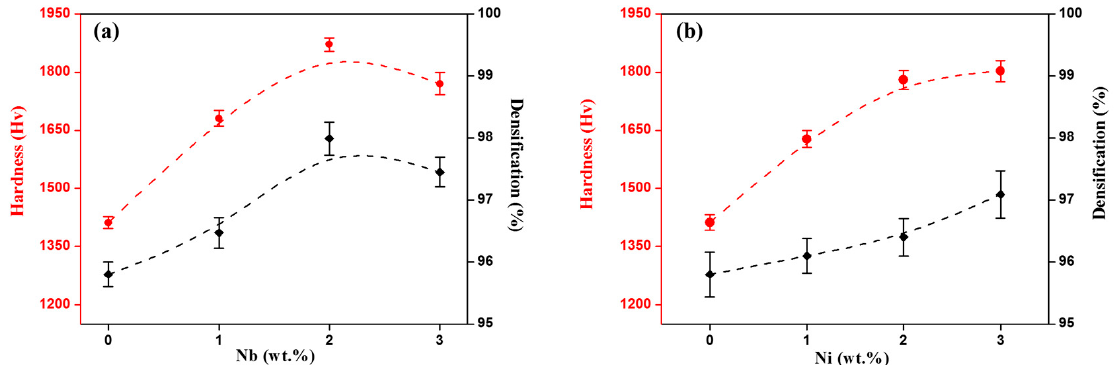
Figure 5. Densification and hardness plot of the Al 2 O 3 -TiC composite samples with different wt. % of ( a ) Nb and ( b ) Ni binder addition.